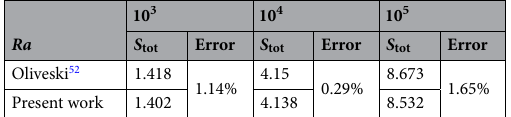
Table 3. Comparison of average entropy for different Ra